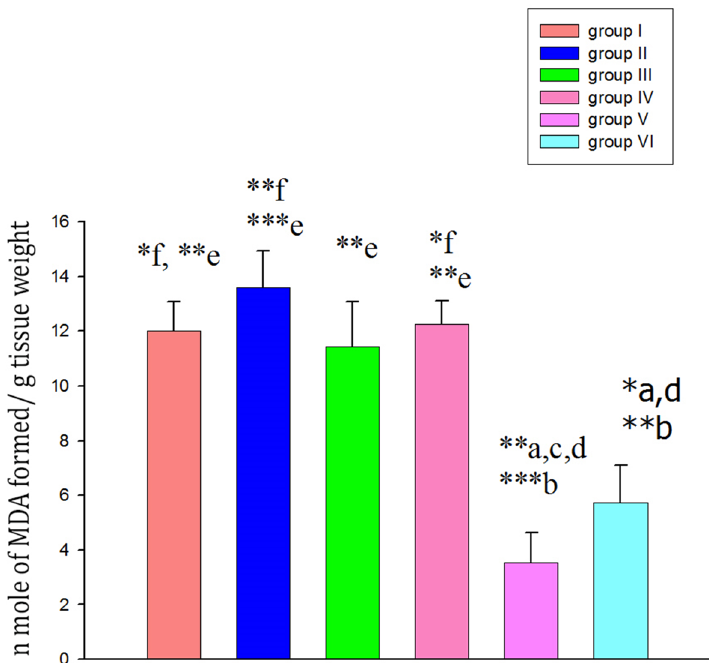
Figure 1. TBARS level in brains of differently treated mice. Results are expressed as mean ± S.E. * = p < 0.05, ** = p < 0.01, *** = p < 0.001, a = compared to group I, b = compared to group II, c = compared to group III, d = compared to group IV, e = compared to group V, f = compared to group